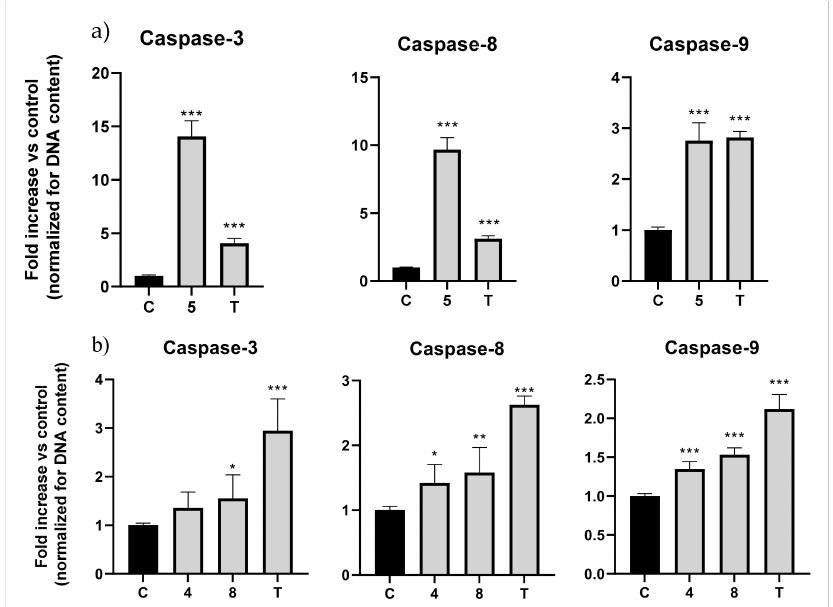
Figure 4. Fold increase (normalized for DNA content) in caspase-3, -8, and -9 activation in ( a ) AGS with molecule 5 and ( b ) A549 with molecules 4 and 8 . Topotecan at 2.5 µ M was used as positive control. The values were normalized for DNA content; C: control; T: topotecan. * p < 0.05; ** p < 0.01; *** p <